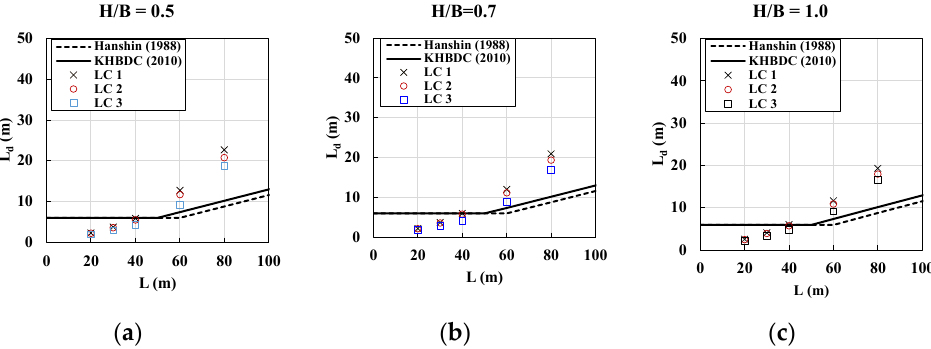
Figure 14. Comparisons between the design intermediate diaphragm spacing in the design codes and minimum required intermediate diaphragm spacing for different spans and load combinations at the 5% normal stress ratio. ( a ) 𝐻/𝐵 = 0.5 , ( b ) 𝐻/𝐵 = 0.7 , and ( c ) 𝐻/𝐵 = 1.0 .